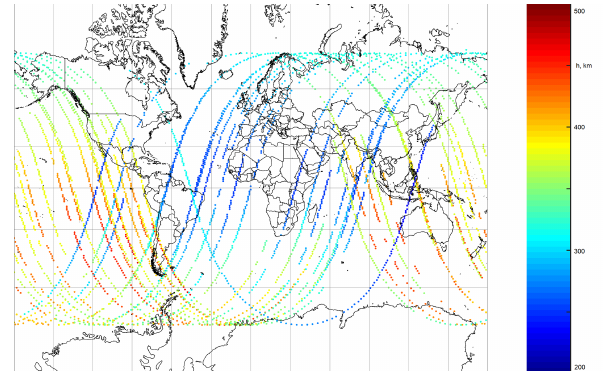
Figure 11. Spatial coverage of available Kosmos-321 data.